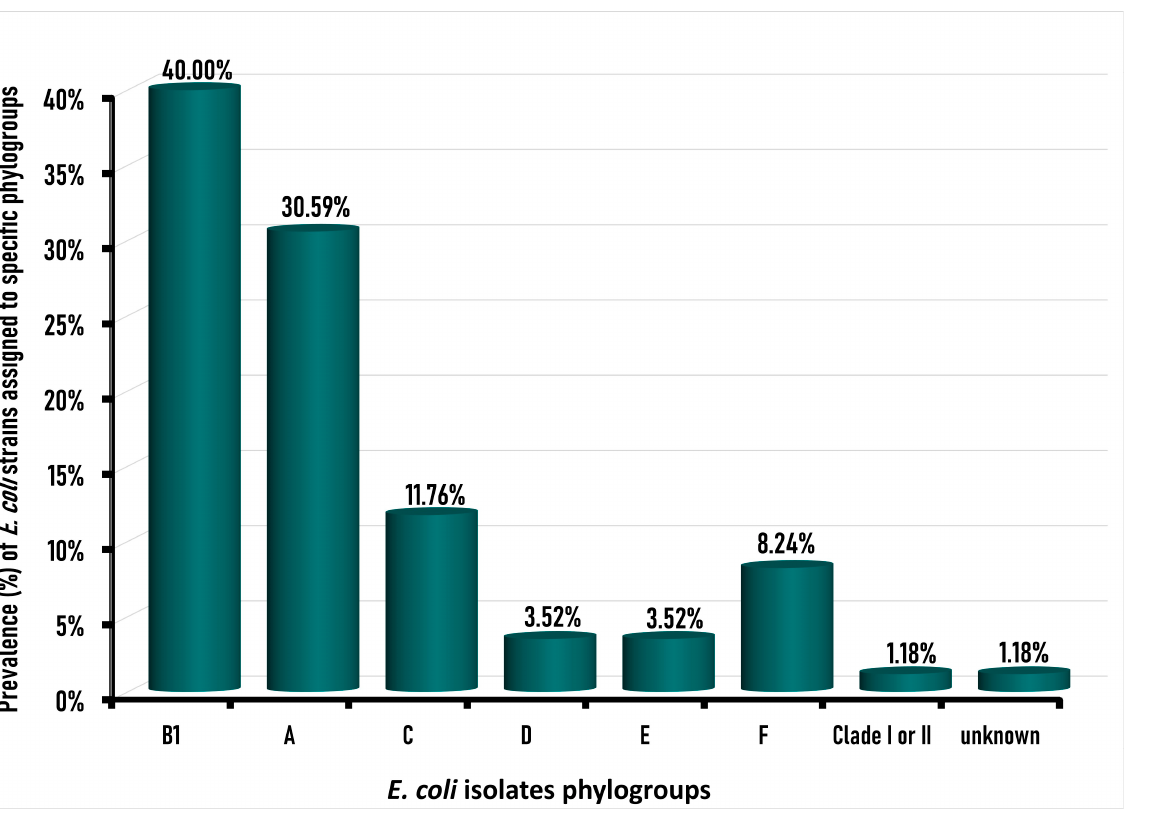
Figure 3. Prevalence of different phylogroups among total Escherichia coli isolates ( n = 85). Among the 85 E. coli isolates, the majority (70/85; 82.35%) were identified as commen- sal strains with a phylogroup of B1, A, or C, divided into phylogroup B1 (34/85; 40%), followed by phylogroup A (26/85; 30.59%), and phylogroup C (10/85; 11.76%). The path- ogenic phylogroup E. coli was detected in 13 (15.29%) of the 85 E. coli isolates, which were distributed as 7 (8.24%) phylogroup F, 3 (3.52%) for each of D and E phylogroups, and only 1% was Clade I or II, with an absence of phylotype B2. The amplification of the genes incorporated in the phylogroup typing of the confirmed E . coli strains is presented as a supplementary figure (Figure S3) showing a representative agarose gel electrophoresis of the DNA for the arp A, chu A, yja A, and trp A (quadruplex PCR), along with TspE4C2, trp A (group C) (singleplex), and arp A (group E).